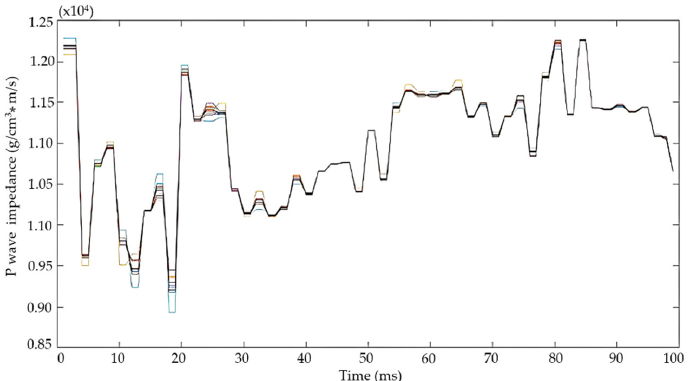
Figure 4. Single channel multiple particle inversion results.